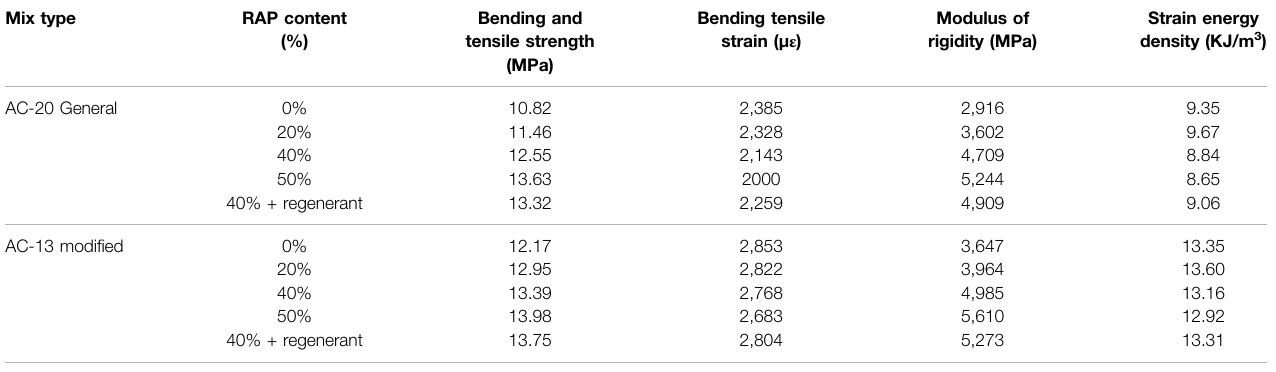
TABLE 7 | Semicircular splitting test results of different asphalt recycled mixes ( − 10 ° C).